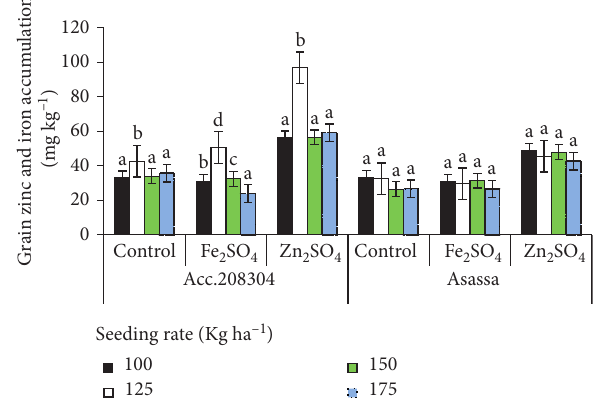
Figure 4: Grain Zn and Fe concentrations (mg kg − 1 ) due to the interaction between varieties, seeding rate, and microfertilizers. Bars separated with different letters are statistically different from each